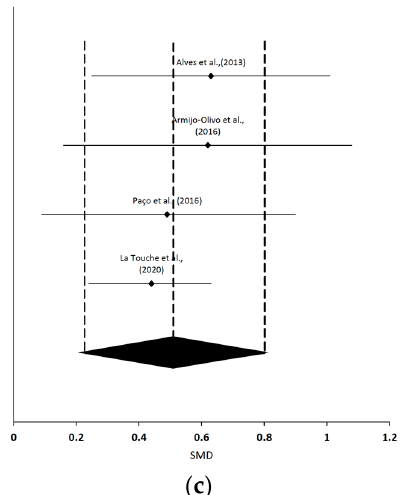
Figure 4. ( a ) The forest plot summarizes the results of included studies (standardized mean differ- ences (SMD) and weight). The small squares represent the point estimate of the effect size and sample size. The lines on either side of the box represent a 95% confidence interval [15,57,60,63]. ( b ) Funnel plot aims to assess the existence of publication bias. ( c ) Sensitivity plot.